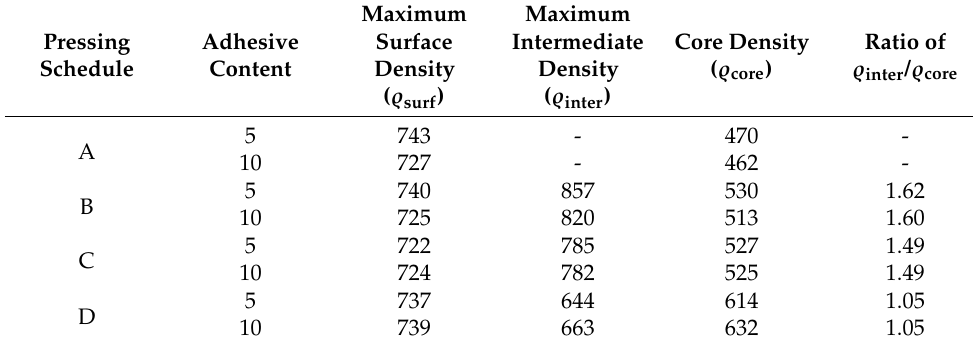
Table 3. Characteristic values of density profile for various pressing